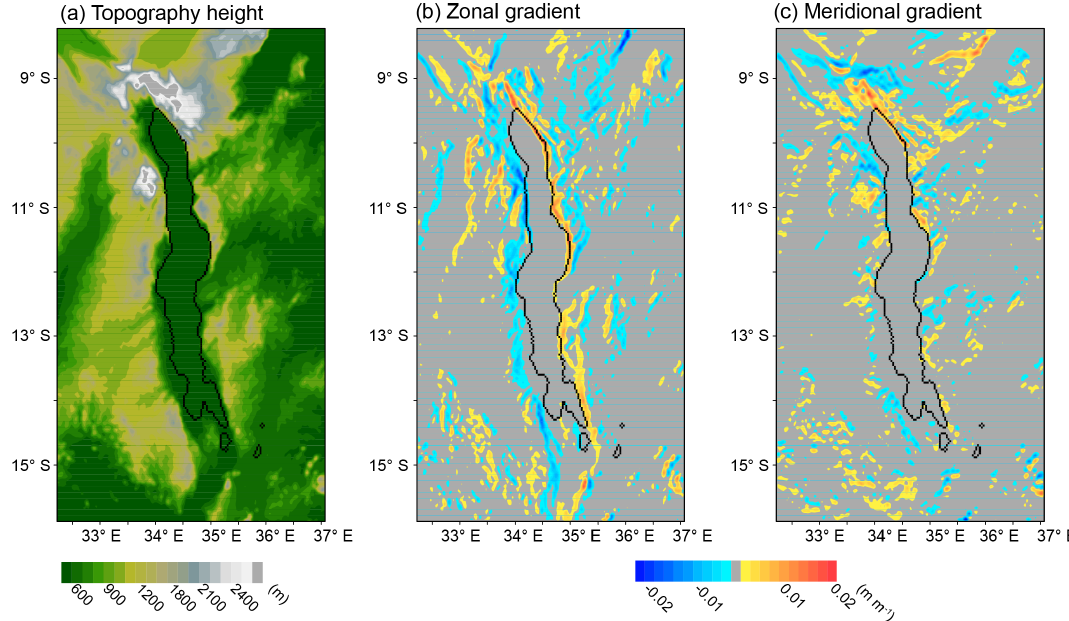
Figure 9. The distribution of topography around Lake Malawi. (a) Topographic altitude in the WRF inner domain and its zonal and meridional gradients in (b) and (c)